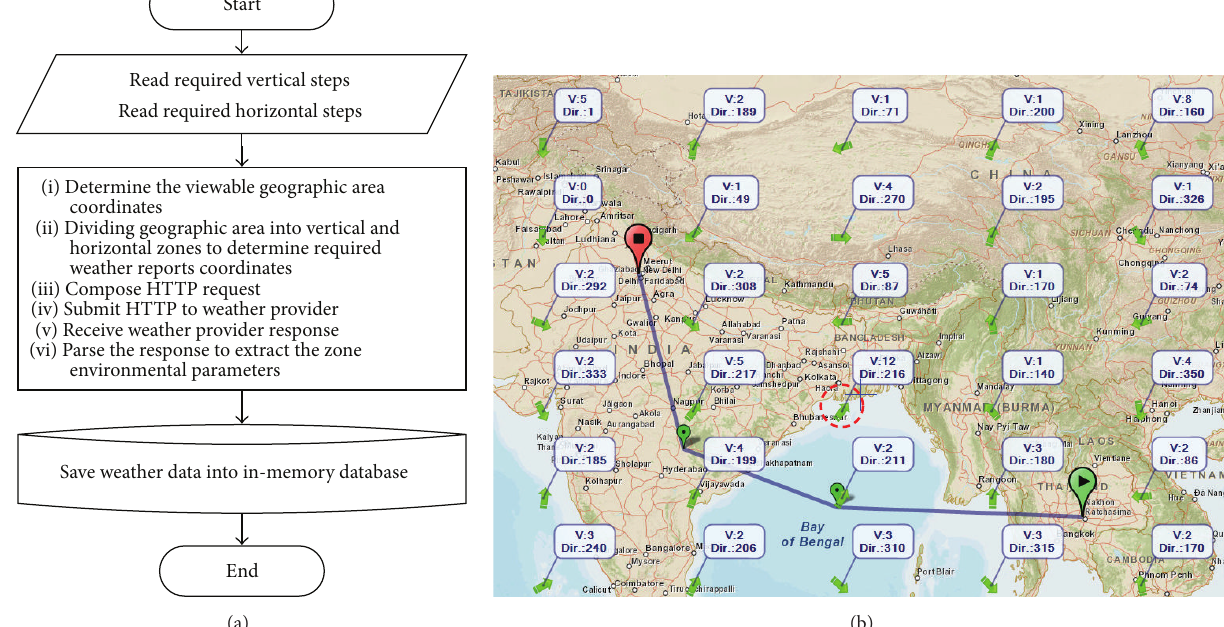
Figure 8: Integration of global weather forecasting reports with the mission planning process (a) weather interface module flowchart and (b) mission planning using synthetic graphical weather layer.